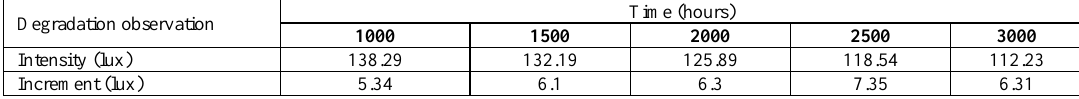
Table 6. Simulated LED degradation data at normal operating